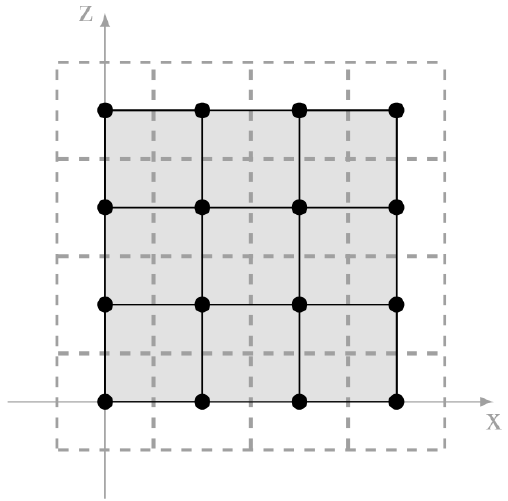
Figure 2. Schematic of a 2-D computational domain. Bullets mark the data points for the dependent variable ψ in Eq. (18), solid lines depict the edges of the primary grid and dashed lines mark the edges of the dual grid. Reproduced from Jaruga et al.